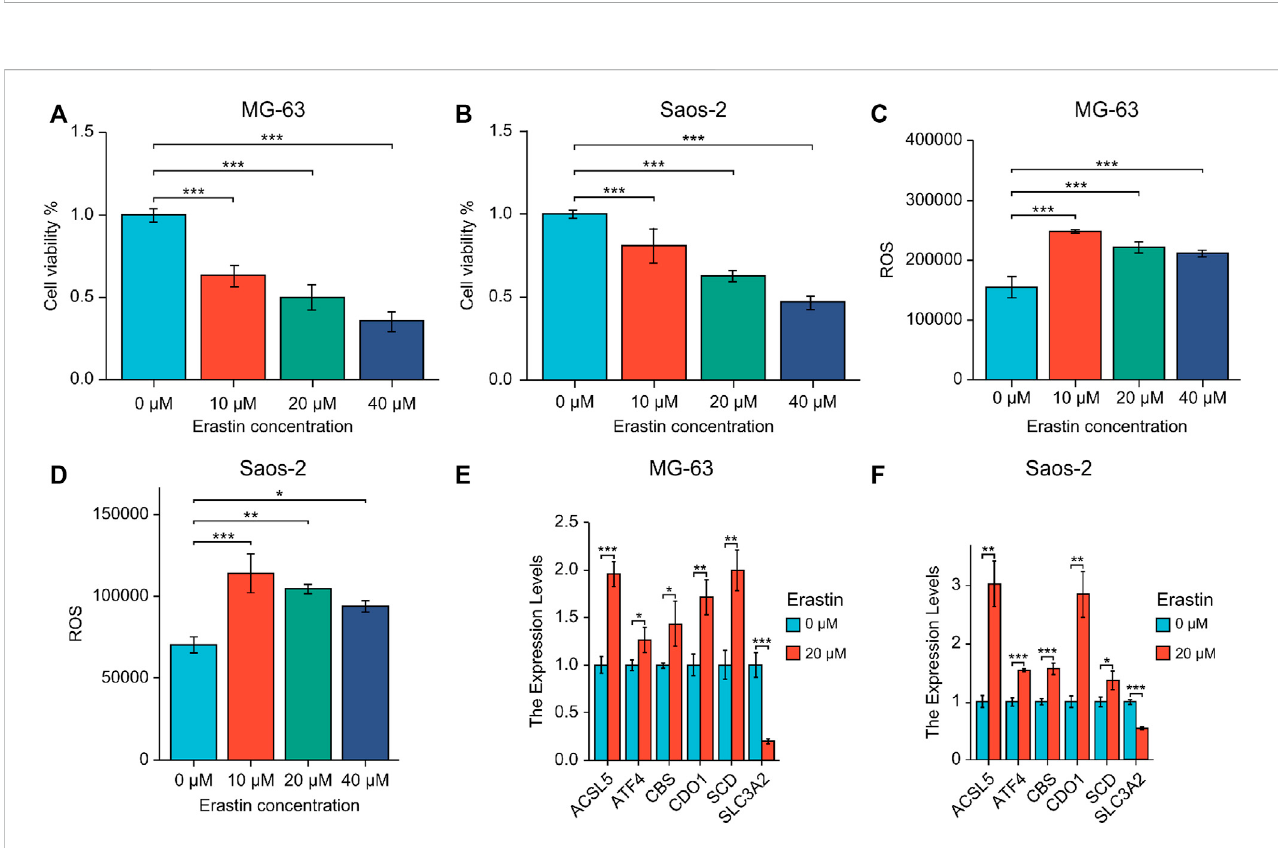
FIGURE 9 (A, B) Expression of six prognostic genes in MG-63 (A) and Saos-2 (B) cells treated with erastin. (C, D) Lipid peroxidation experiments were performed using erastin-treated MG-63 (C) and Saos-2 (D) cells via fl ow cytometry. (E, F) Real-time PCR of six core prognostic genes of MG-63 (E) and Saos-2 (F) cells upon 20 μ M erastin treatment for 48 h. * p < .05; ** p < .01; *** p < .001. ROS, reactive oxygen